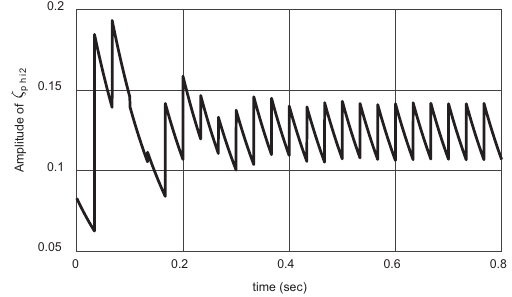
Figure 6 . Time history of